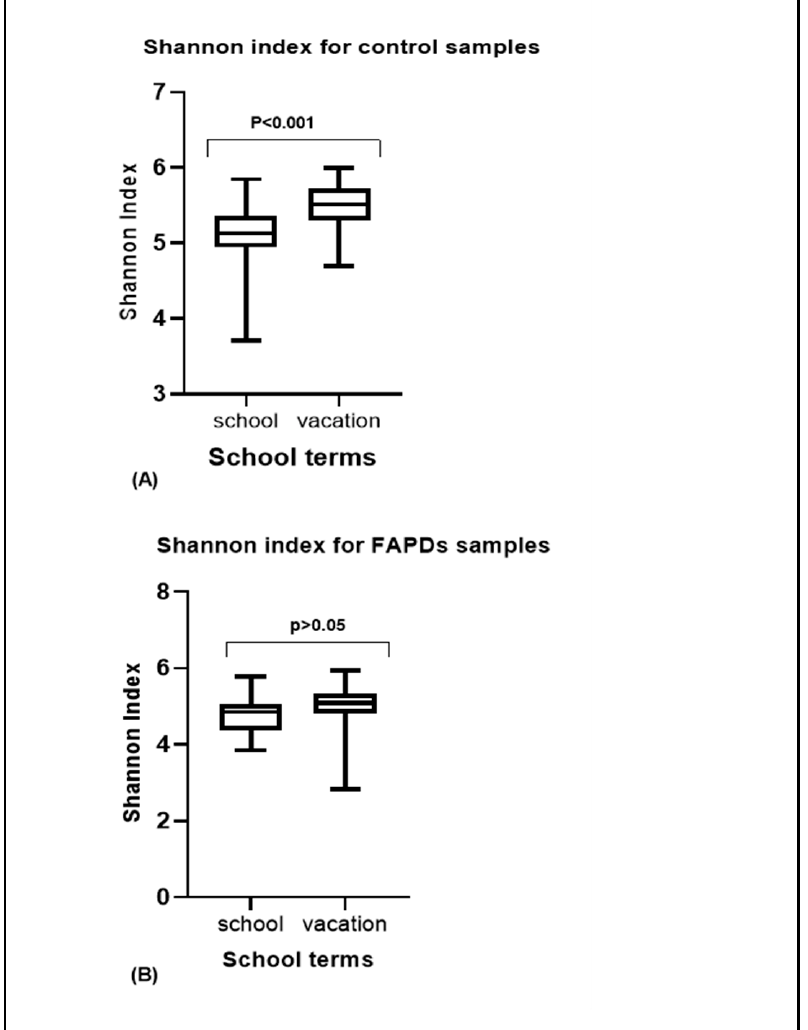
Figure 4. Alpha diversity (Shannon index) comparison between the control ( A ) and FAPDs ( B ) in the two school terms. p < 0.05 was considered significant.